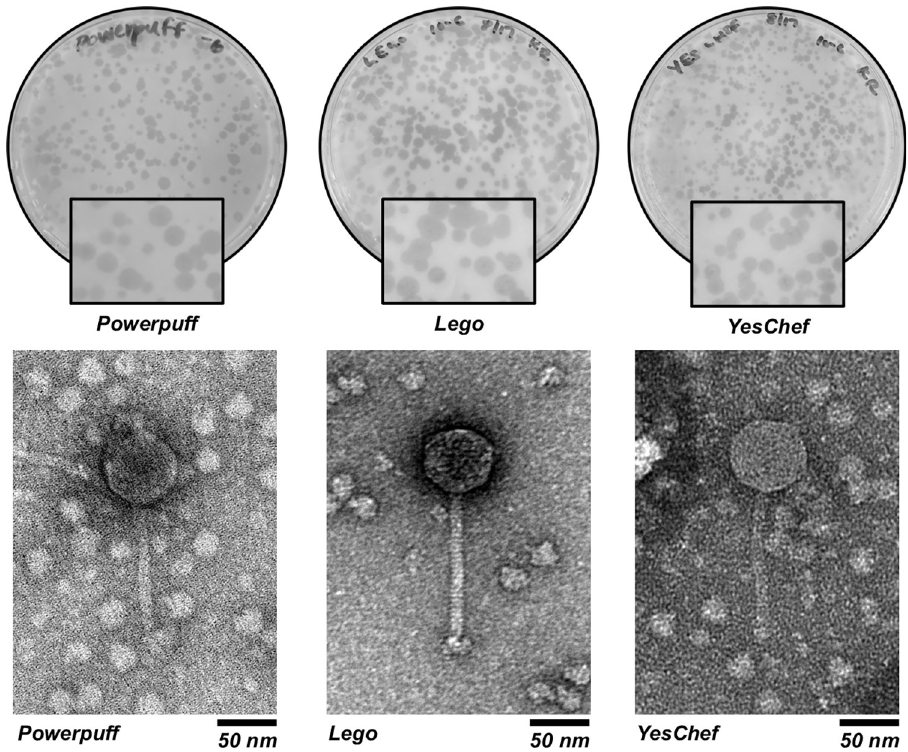
Fig 1. Phages Powerpuff, Lego, and YesChef exhibit turbid bullseye plaque morphologies and are Siphoviridae . Purified phage lysates were plated using the double agar overlay method. Each phage exhibited 1–3 mm turbid bullseye plaques, suggestive of a lysogenic life cycle. The presence of long, flexible tails supported their classification as Siphoviridae .